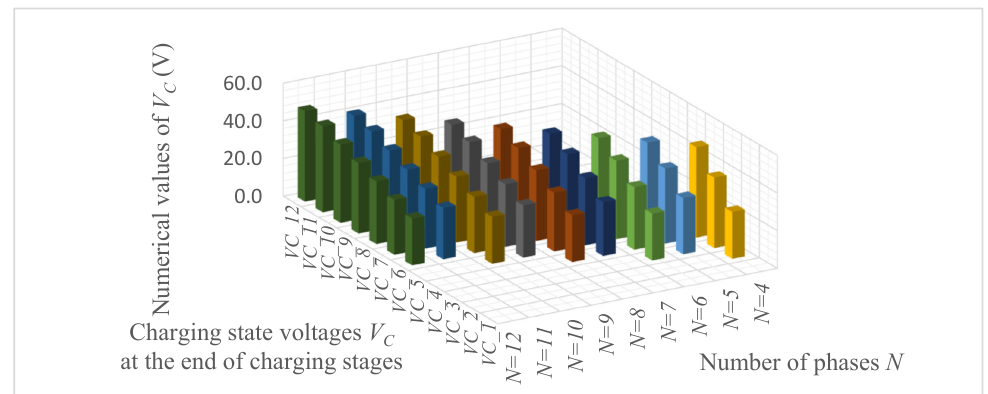
Figure 11. SC charging state voltages at which switching to the next duty cycle is performed.